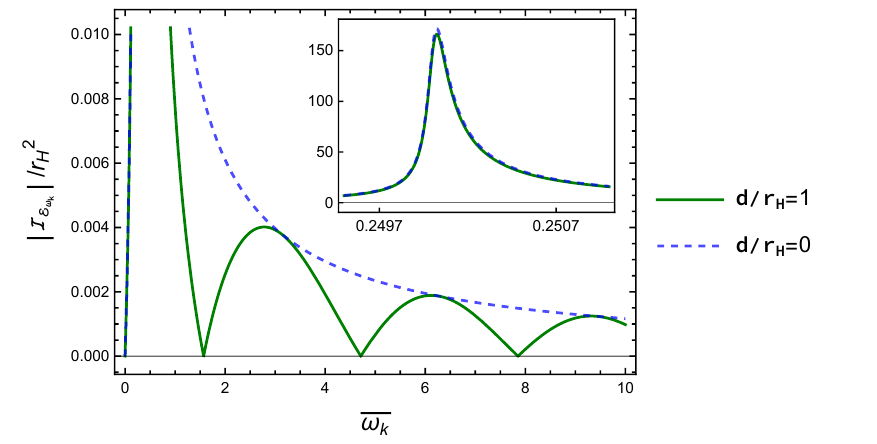
Figure 3 . The quantity I j Schwarzschild black hole spacetime with respect to the frequency of the field ω detector transition energies ∆ E A = r is independent of the parameter d . I j ωk